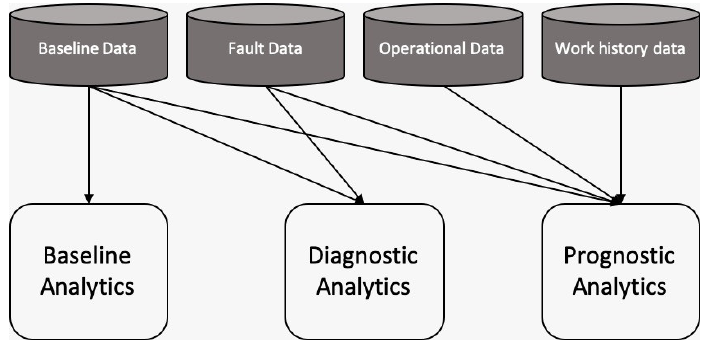
Figure 7. Types of analytics based on their applications. Adapted from [11].